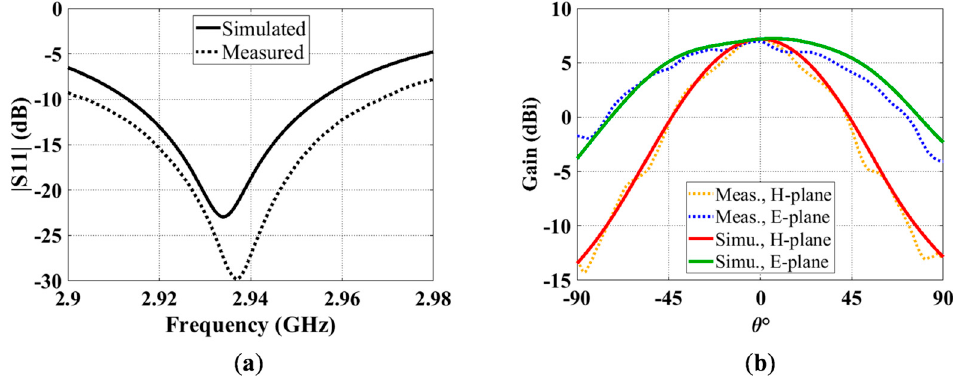
Figure 7. Simulated (solid) and measured (dashed) results of the fabricated split ring antenna: ( a ) S11; ( b ) E- and H-plane radiation patterns at 2.937 GHz.